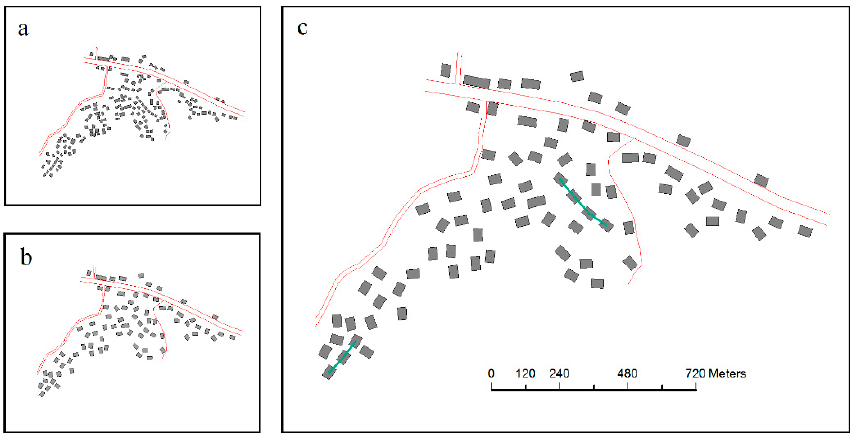
Figure 18. Test results of selection unit A: ( a ) visual reduction without selection (1:25,000), ( b ) selection result using the GA (1:25,000), and ( c ) selection results enlarged to 1:10,000 from 1:25,000.